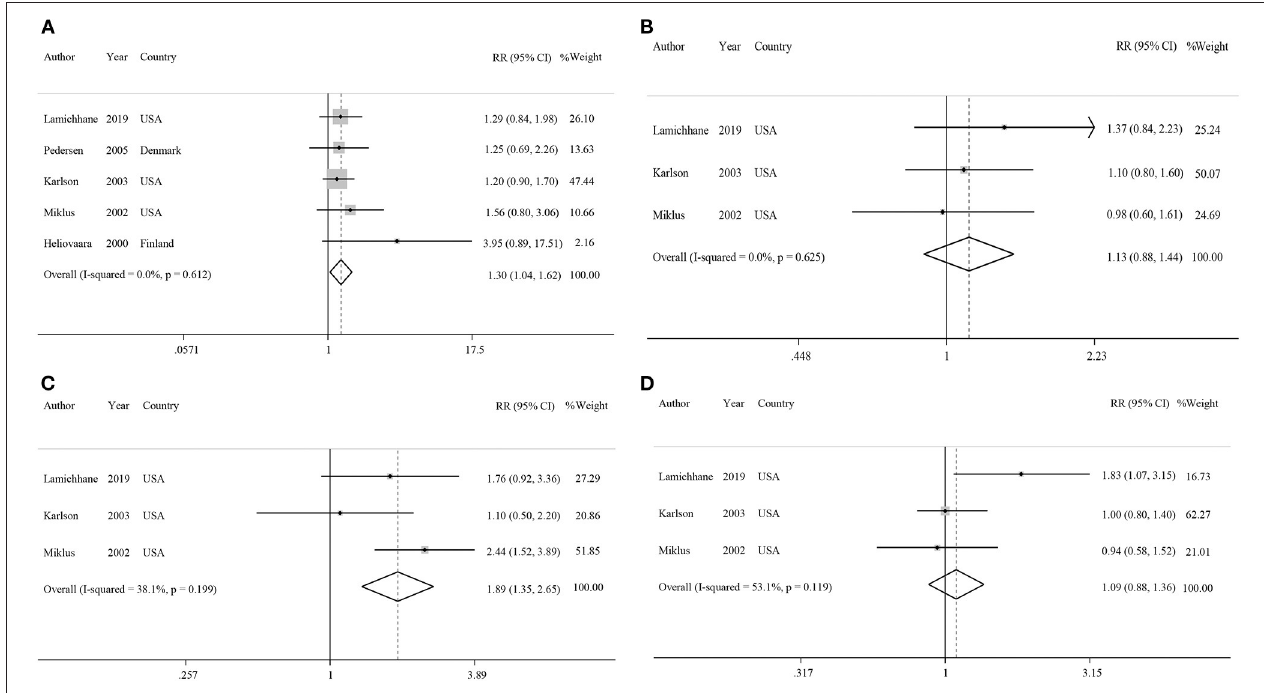
FIGURE 2 | Forest plots showing relative risks of developing rheumatoid arthritis for highest vs. lowest categories of (A) coffee intake, (B) caffeinated coffee intake, (C) decaffeinated coffee intake, and (D) caffeine intake.